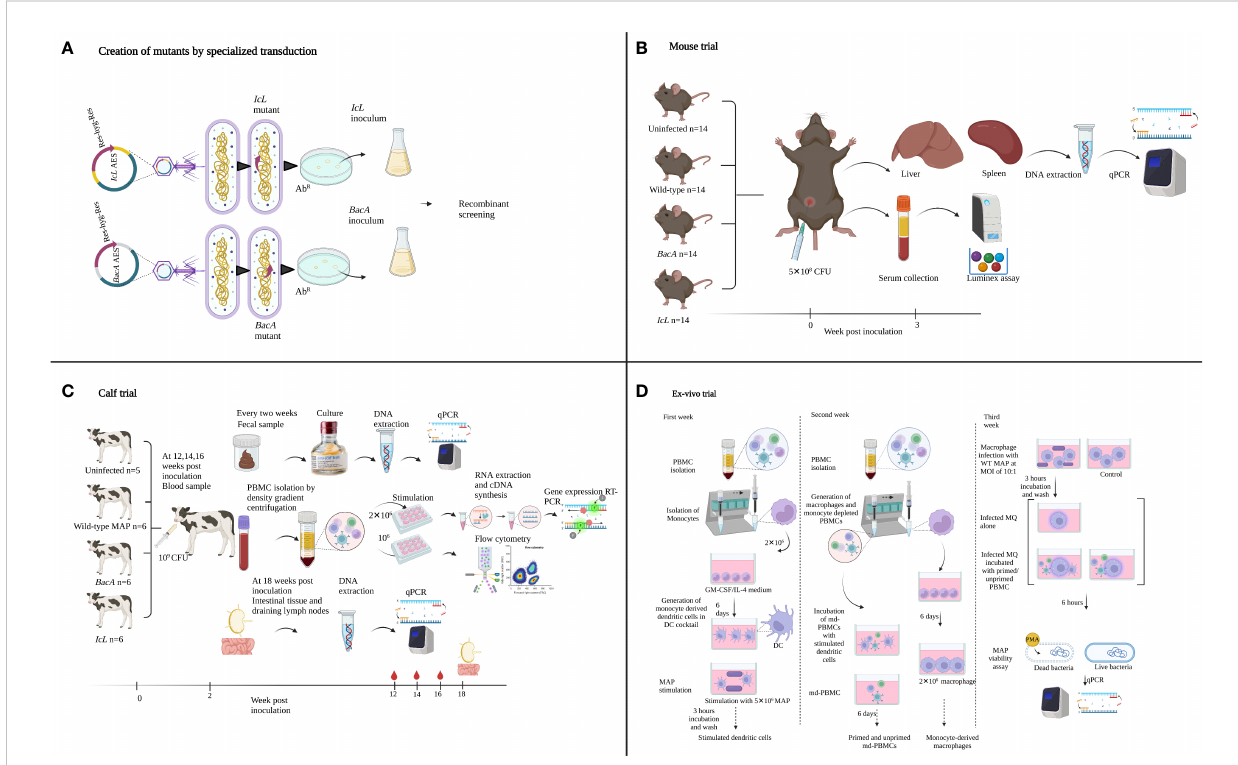
FIGURE 1 Summary of the experimental methods used to create and evaluate MAP IcL and BacA mutants in mouse, calf, and ex-vivo trials. Illustrations were created in